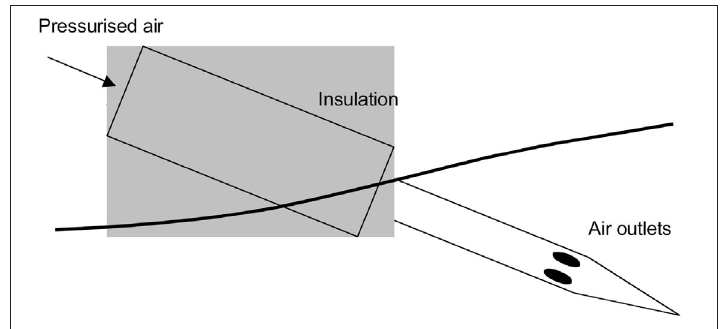
Fig. 4. Drawing of lance, cone end with holes and insulated air inlet.